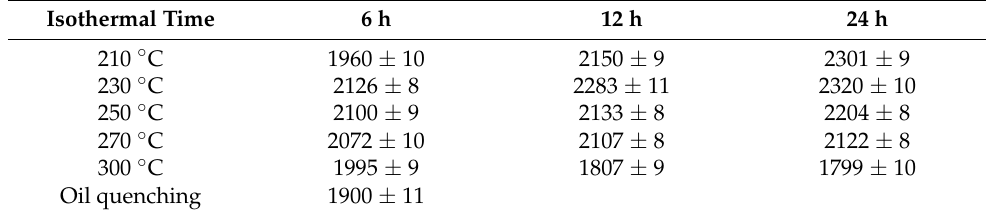
Table 6. Tensile strength of different isothermal